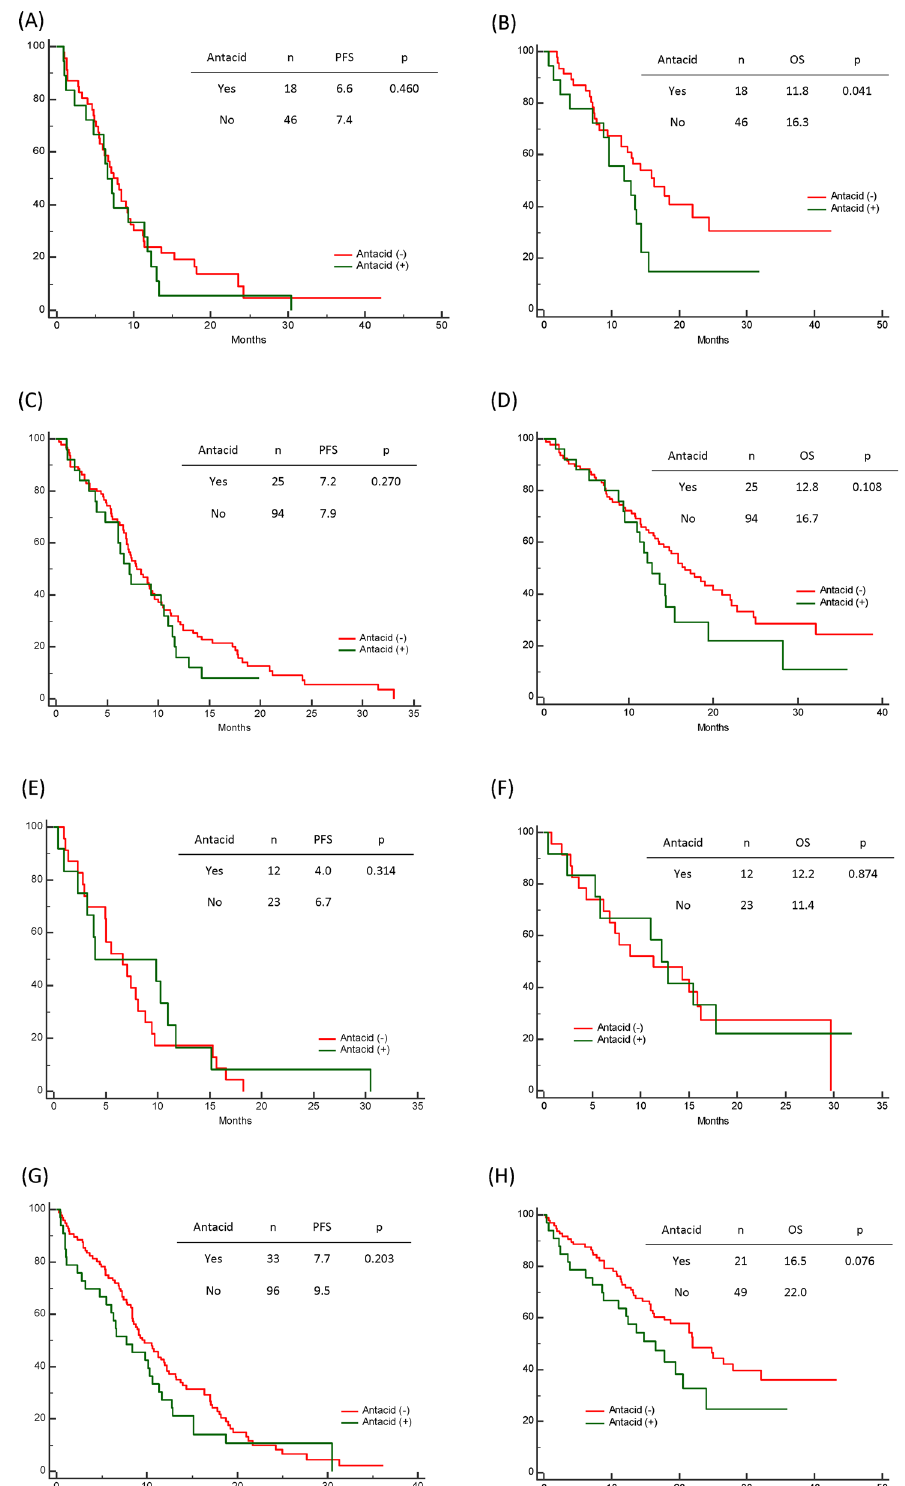
Fig 3. The effect of antacids use and metastasis sites on progression-free survival (PFS) and overall survival (OS) among patients with epidermal growth factor receptor-mutant non-small-cell lung cancer who were treated using first-line tyrosine kinase inhibitors. (A) PFS and (B) OS among